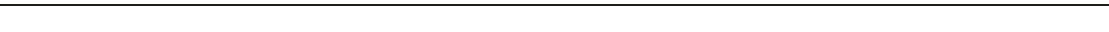
Fig. 4 Energy metabolism and water turnover. a – l Indirect calorimetry was conducted over a period of 47 h, initiated at 7 a.m. (young + AL: n = 16, young + EOD: n = 16, old + AL: n = 16, old + EOD: n = 16). The dark/light cycle was kept at 12:12 h (lights on 6 a.m. CET, lights off 6 p.m. CET). For mice assigned to the EOD cohorts, food was removed after the fi rst 24 h. Water was supplied AL to all groups. Temporal pattern of a oxygen consumption, b carbon dioxide production, c HP, d distance moved, e food intake, and f respiratory exchange rate are shown. g Oxygen consumption, h carbon dioxide production, i HP, j food intake, and k water consumption per g body weight as well as l mean respiratory exchange rate were calculated. m TEWL was measured non- invasively using a special Tewameter (young + AL: n = 15, young+ EOD: n = 16, old+ AL: n = 22, old +EOD: n = 23). Statistical analyses of a – f were